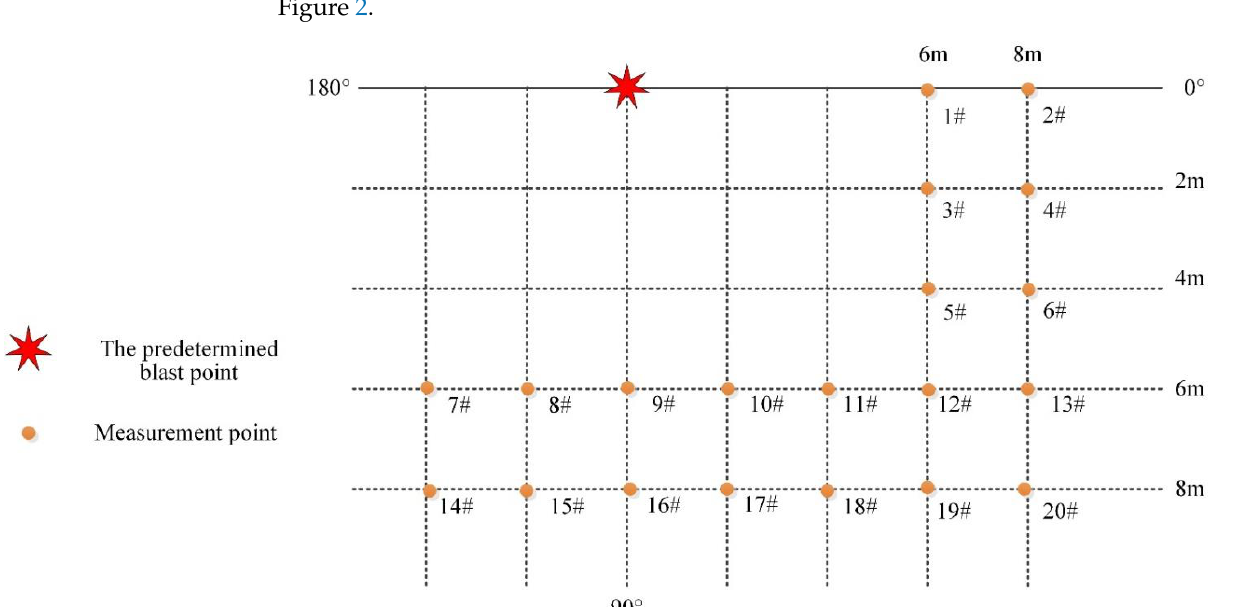
Figure 1. Schematic of the measurement points in the stationary charge explosion experiment.